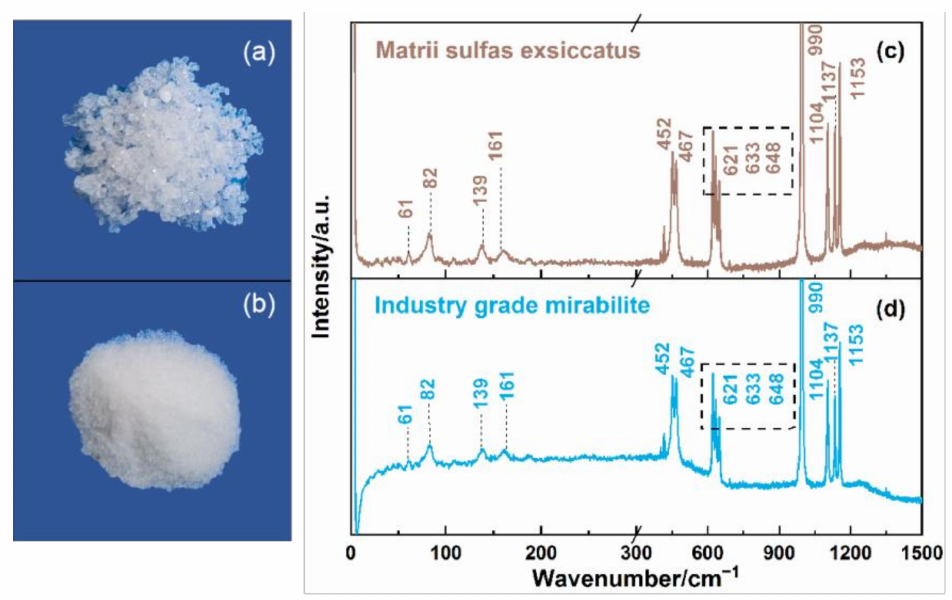
Figure 7. ( a ) Matrii sulfas exsiccatus, ( b ) industrial grade mirabilite, and the Raman spectra of ( c ) matrii sulfas exsiccatus and ( d ) industrial grade